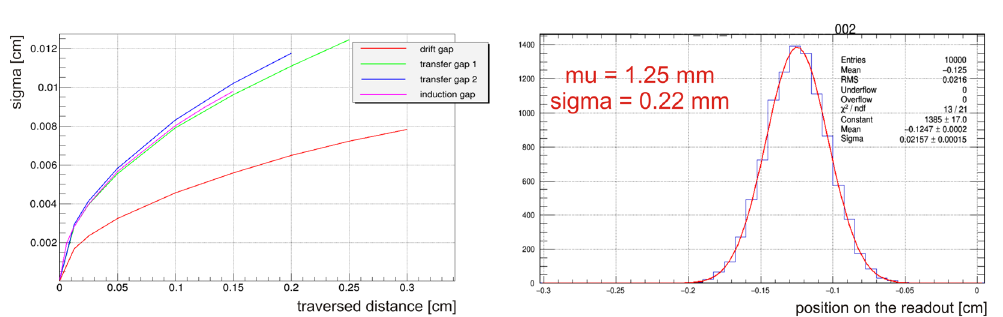
Figure 4. (Left) Dependence of the standard deviation (sigma) of electrons in the transverse drift direction on its traversed distance for all GEM gaps; (right) density distribution of electrons passed through the thickness of the GEM chamber (0.9 cm).